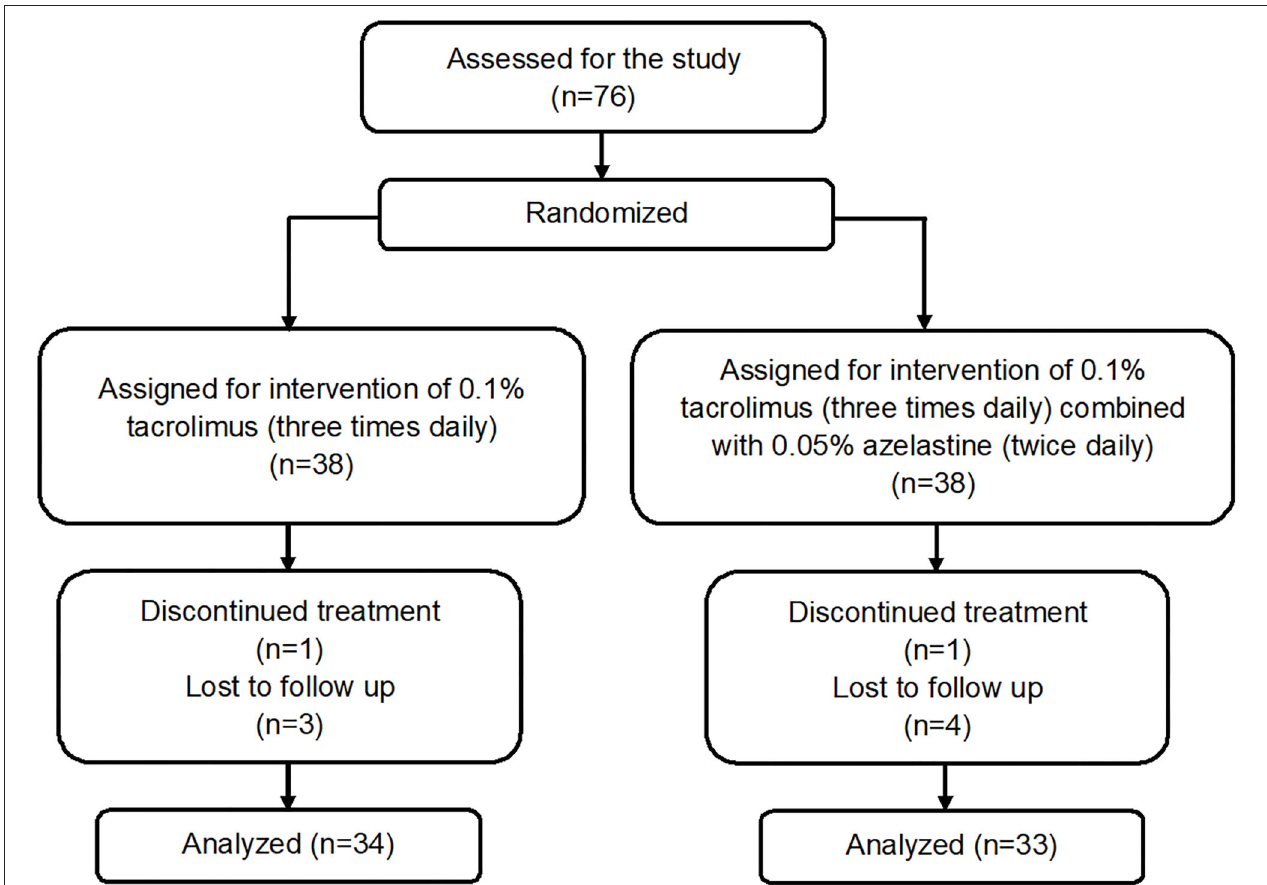
FIGURE 1 | Participant